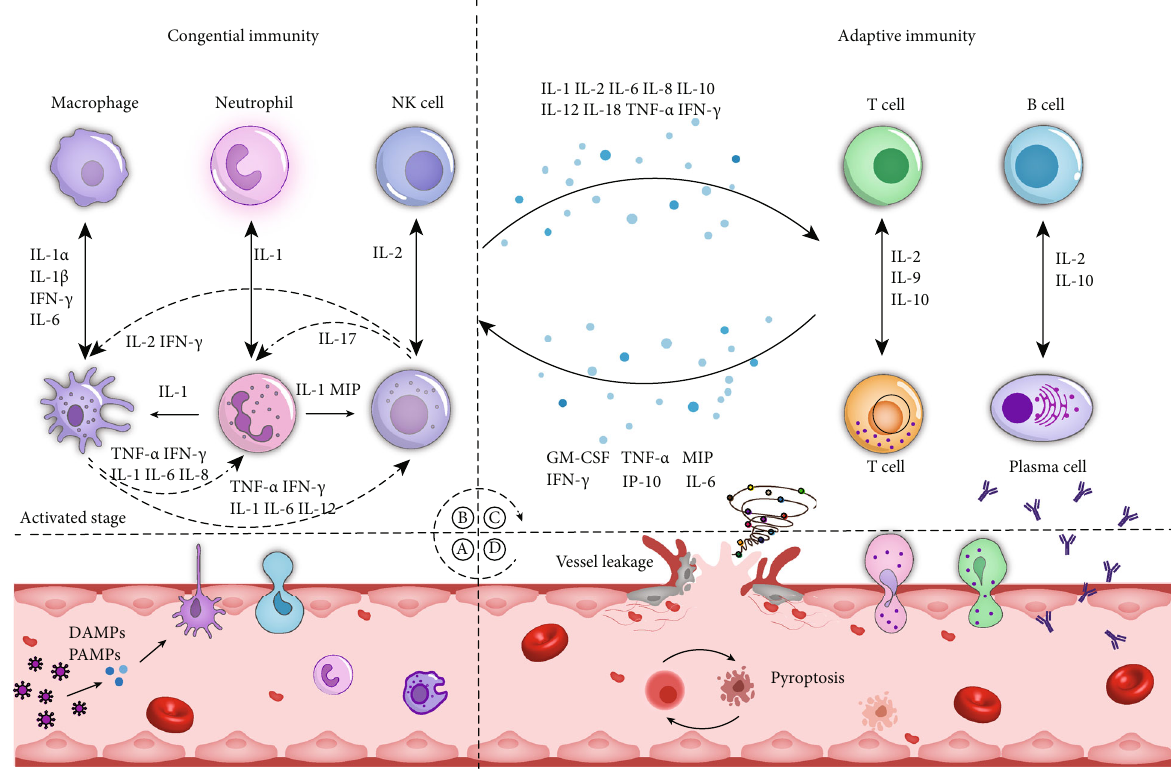
Figure 1: Development of cytokine release syndrome. (a) Antigen presentation: when DAMPs (damage-associated molecular patterns) or PAMPs (pathogen-associated molecular patterns) bind to PRRs (pattern recognition receptors) on the membrane of antigen-presenting cells (APCs) in capillaries, these cells activate immune signal transduction and stimulate immune cells and epithelial cells to release cytokines. (b) Activation of the innate immune system: cytokine secretion results in the recruitment of innate immune cells (e.g., macrophages, neutrophils, and NK cells) in local tissues. (c) Activation of adaptive immune system: innate immune cells further activate adaptive immune cells (T cells and B cells). Immune cells then continue to activate each another, resulting in extensive production of cytokines under the action of positive feedback and causing the formation of a cytokine storm. (d) Cytokine release syndrome: after a cytokine storm is formed, immune cells and the cytokines released by them continue to induce capillary leakage and pyroptosis, which can lead to severe organ structural destruction and functional failure. IP-10: interferon-inducible protein 10; MIP: macrophage in fl ammatory protein; GM-CSF: granulocyte-macrophage colony-stimulating factor; IL: interleukin; TNF- α : tumor necrosis factor- α ; IFN- γ : interferon- γ ; NK cells: natural killer